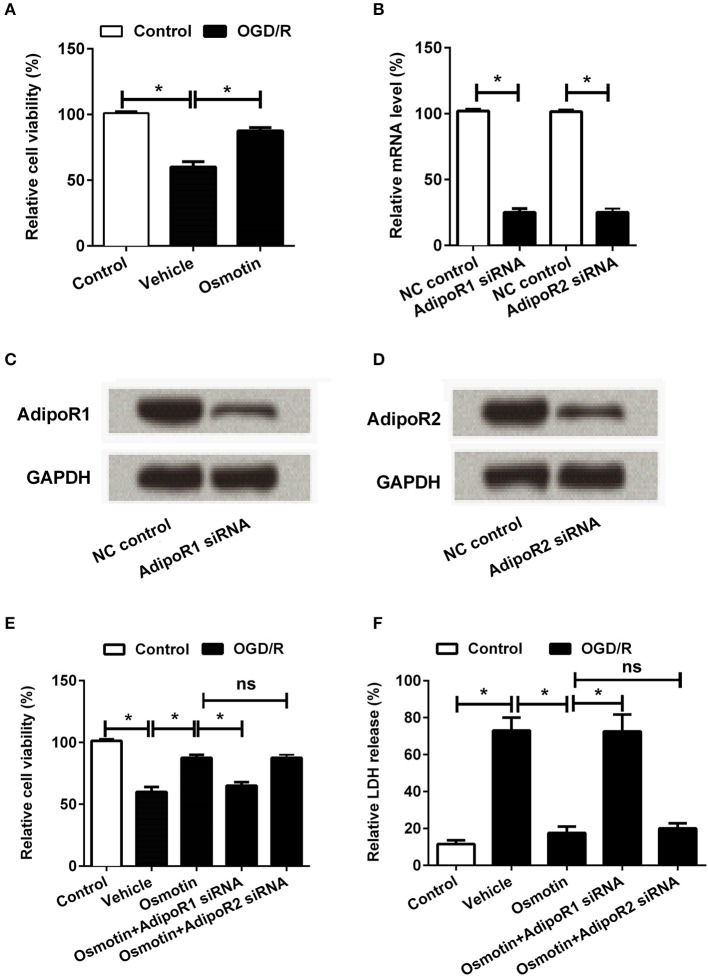
Effects of osmotin combine with AdipoRs silence on H9c2 cell viability. H9c2 cells were pre-treated with OGD/R, and then been administrated with osmotin and/or transfection with specifically siRNAs for AdipoR1 or AdipoR2. (A) Effects of osmotin on the cell viability (n = 5); (B–D). Transfection efficiency of siRNAs for AdipoR1 and AdipoR2 were measured by semi-qRT-PCR (n = 5), and western blot assay. GAPDH acted as internal control; (E) Effects of osmotin and/or combine with AdipoR1 or AdipoR2 siRNAs transfection on cell viability (n = 5). (F) Relative LDH release of H9c2 cells after corresponding administrations (n = 5). *P < 0.05 compare to corresponding control; ns, no significant compared to the osmotin group. OGD/R, oxygen and glucose deprivation/reperfusion; AdipoR, adiponectin receptor; NC, negative control; siRNA, small interfering RNA; semi-qRT-PCR, semi-quantitative Real-time reverse transcriptase polymerase chain reaction; LDH, lactate dehydrogenase.